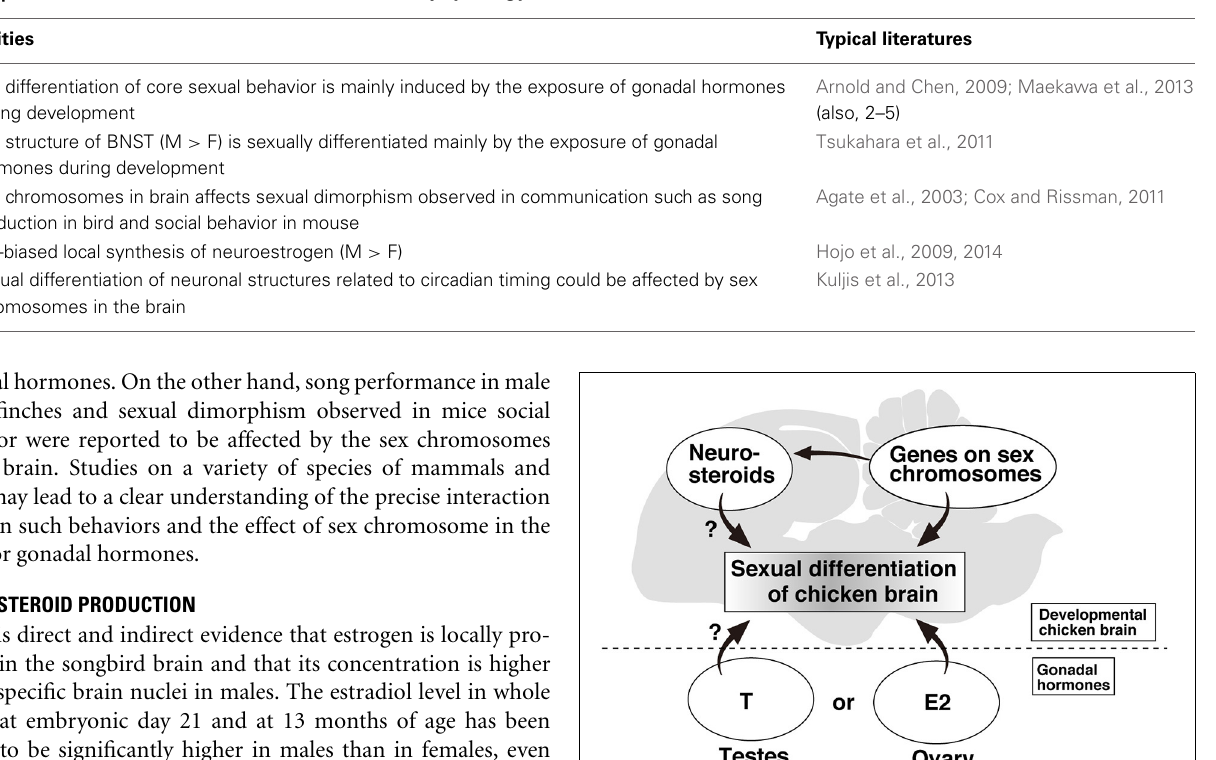
Table 1 | Possible similarities of sex differences in brain, physiology and behavior in mammals and birds.